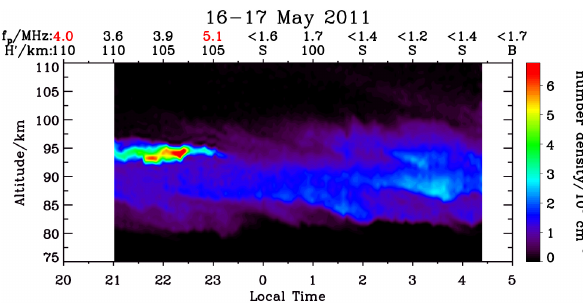
Figure 3. Na density contour plot and E s layer parameters during the night of 28–29 February 2008. Note an extremely strong Na s layer burst around 22:39LT without any E s layer throughout the night.